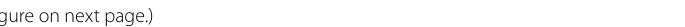
figure on next Fig. 6 Surface morphology of Mfp3-GvpA and Mfp5-CsgA ( A ). Phase image of protein Mfp3- GvpA in PH 5.5 ( B ). topography image of Mfp3-GvpA in pH5.5 ( C ). 3D image of Mfp3-GvpA in pH 5.5 ( D ). Phase image of protein Mfp3-GvpA in pH 2.6 ( E ). topography image of Mfp3-GvpA in pH2.6 ( F ). 3D image of Mfp3-GvpA IN PH 2.6 ( G ). Phase image of protein Mfp5-CsgA in pH 5.5 ( H ). topography image of Mfp5-CsgA in pH5.5 ( I ). 3D image of Mfp 5-CsgA in pH 5.5 ( J ). Phase image of protein Mfp 5-CsgA in pH 2.6 ( K ). topography image of Mfp5-CsgA in pH2.6 ( L ). 3D image of Mfp 5-CsgA IN pH 2.6 ( M ). Phase image of protein Mfp3-GvpA and Mfp5-CsgA in pH 5.5 ( N ). topography image of Mfp3-GvpA and Mfp5-CsgA in pH5.5 ( O ). 3D image of Mfp3-GvpA, Mfp5-CsgA in pH 5.5 ( P ). Phase image of protein Mfp3-GvpA and Mfp5-CsgA in pH 2.6 ( Q ). topography image of Mfp3-GvpA and Mfp5-CsgA in pH 2.6 ( R ). 3D image of Mfp3-GvpA, Mfp5-CsgA in pH 2.6 ( S